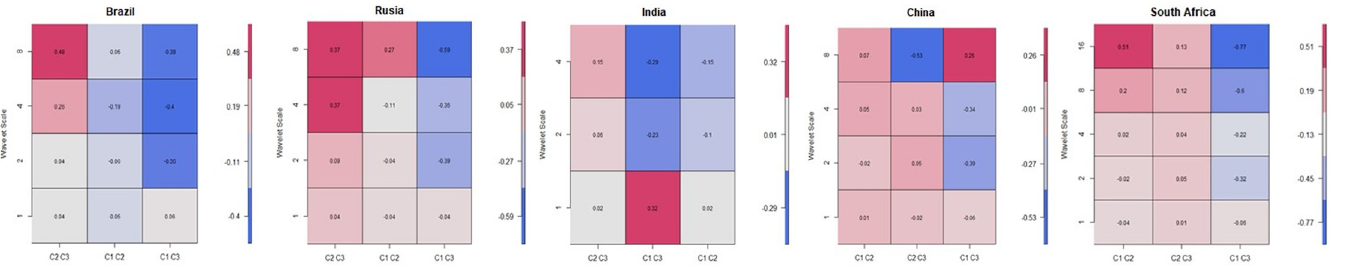
Fig 6. Wavelet bivariate correlations matrix. The codes for the variables are GEPU (C1), GDP (C2) and RFSI (C3).